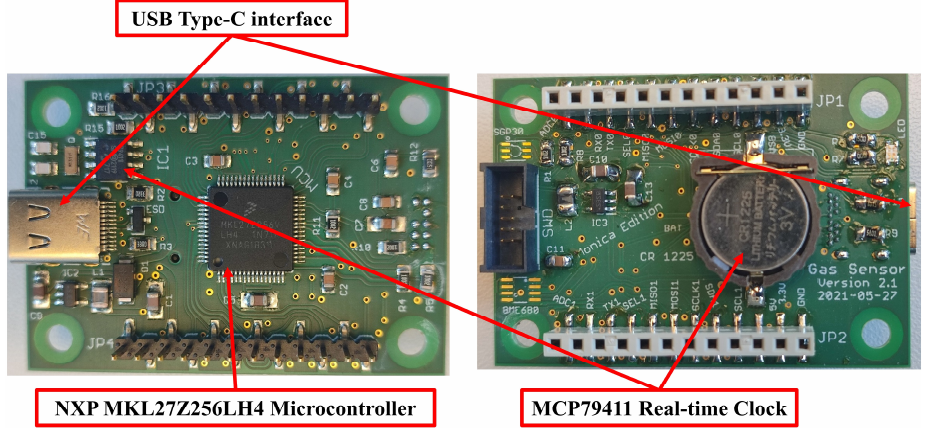
Figure 3. Processing layer (front and back views).